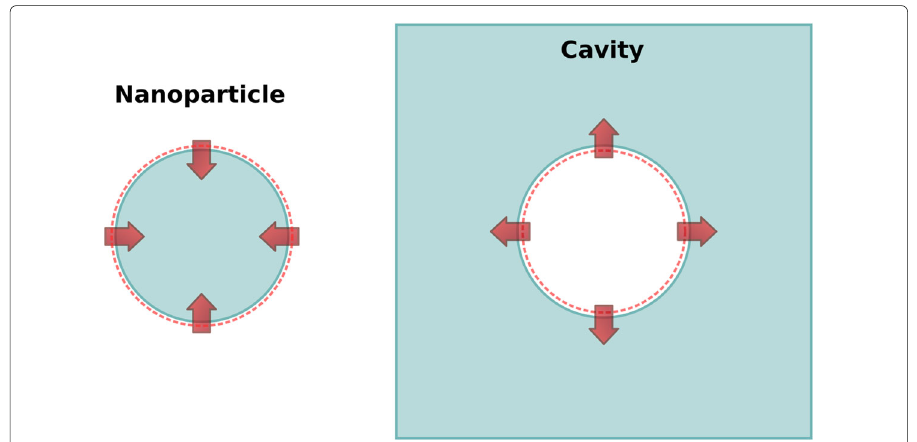
Fig. 1 Models used in simulations. The dashed red line represents the repulsive spherical force field which mimics the effect of an isotropic compression on a nanoparticle (left), and of a pressurized bubble on its surrounding medium